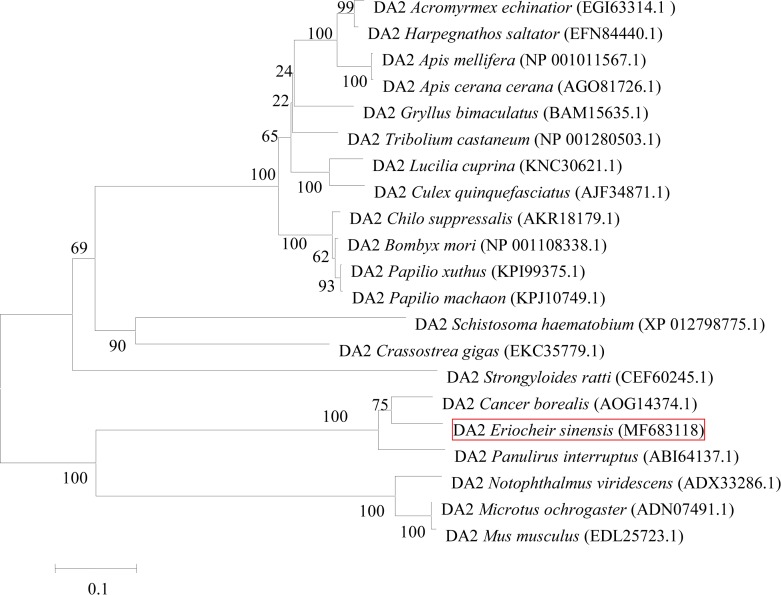
Phylogenetic relationships of the DA2 receptor from E. sinensis and other invertebrates were analyzed with the MEGA 5 program using the neighbor-joining distance analysis.Bootstrap values from 1000 replicates are indicated at the nodes.